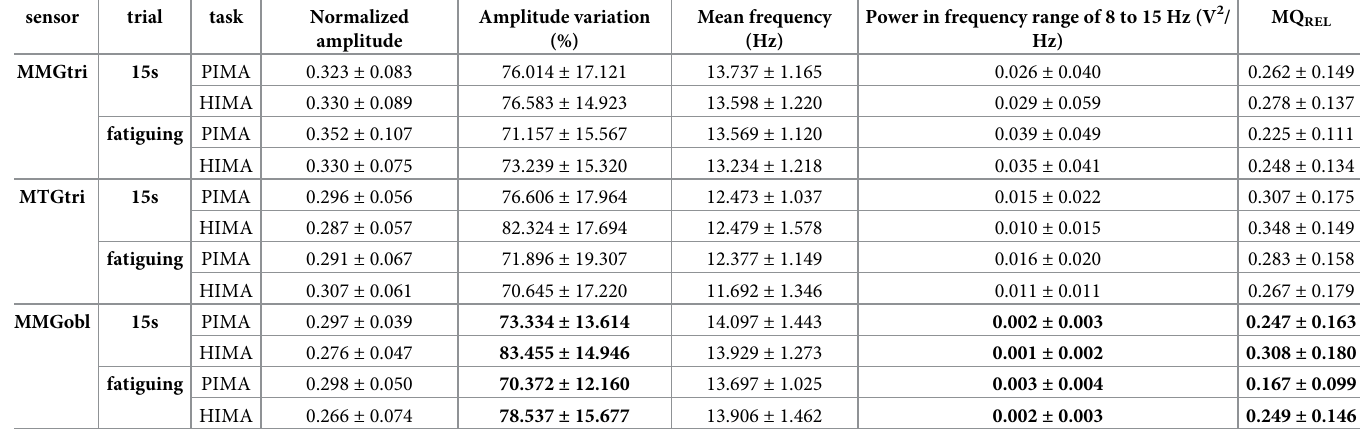
Table 1. Overview of the MMG/MTG